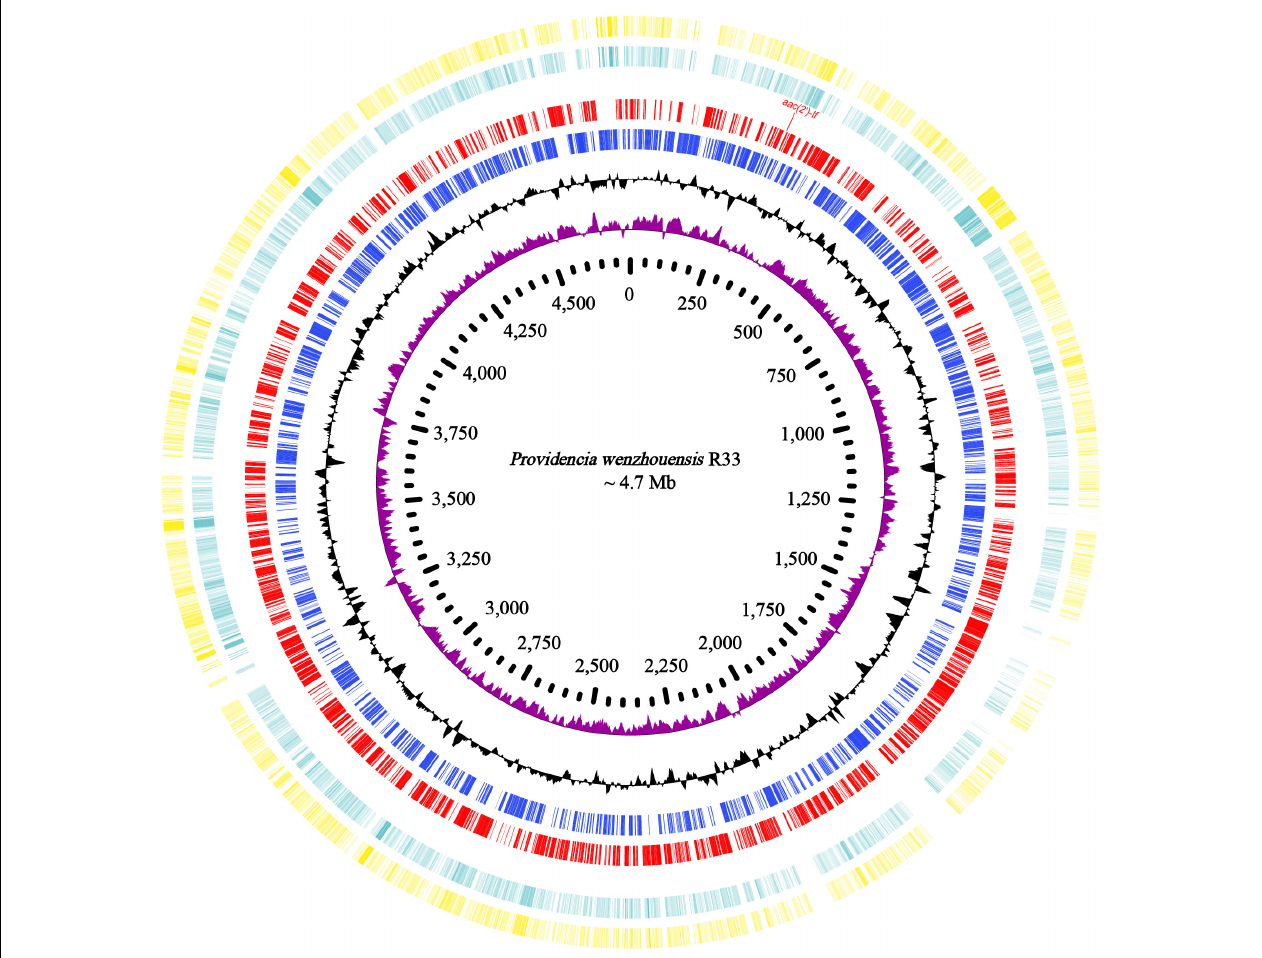
FIGURE 1 | Genome map and comparison of the chromosome sequence of P. wenzhouensis R33 with other similar genomes with high identities. From outside to inside: circles 1 and 2 are homologous regions of the chromosomes of Providencia sp. 1709051003 (NZ_CP042861.1) and P. rettgeri Pr-15-2-50 (NZ_CP039844.1) with P. wenzhouensis R33, while the unmatched regions are left blank; circles 3 and 4 display predicted ORFs encoded in the forward and reverse strands, and circles 5, 6, and 7 represent the GC content, GC skew, and scale in kb of the P. wenzhouensis R33 chromosome,